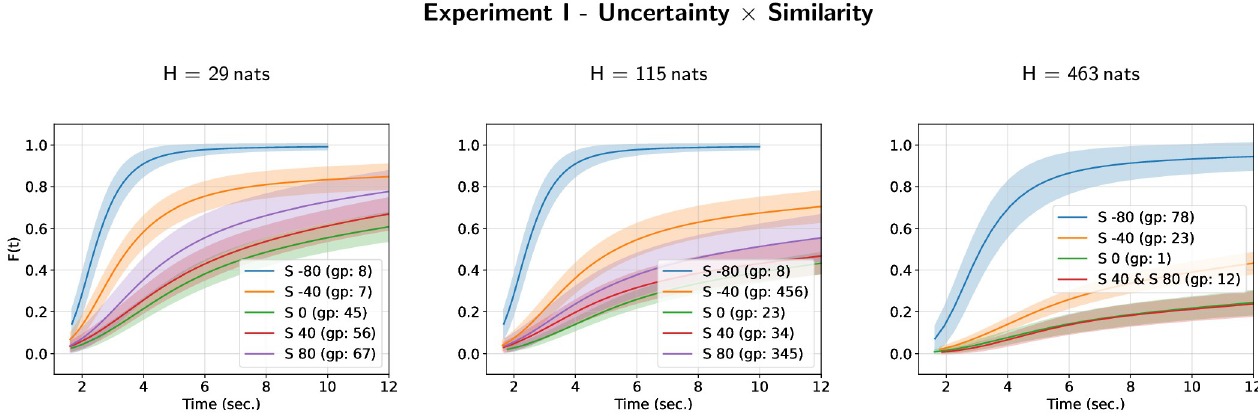
Fig 4. Cumulative distribution functions F ( t ) for masker uncertainty and masker-target similarity in Experiment I. Each figure depicts the estimates of the cumulative distribution functions for each different group of the compact letter display for experimental conditions defined by the interaction between masker uncertainty and masker-target